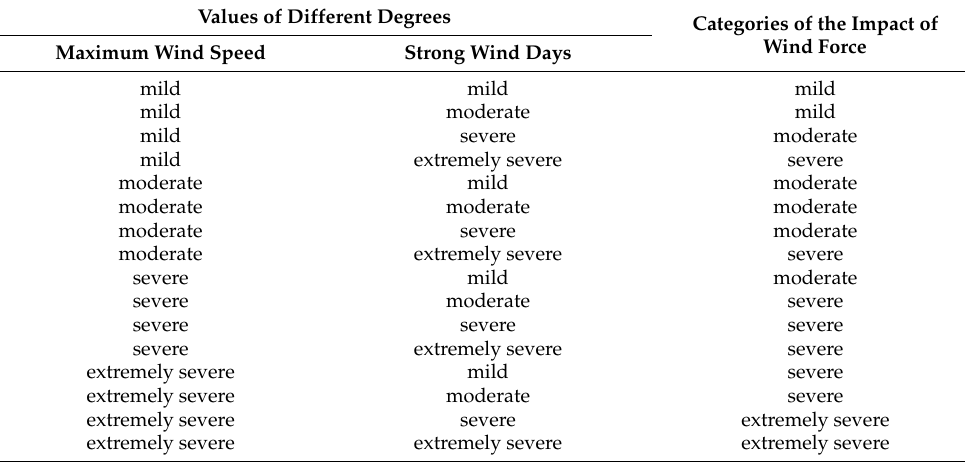
Table 2. Rules for degree classification of wind